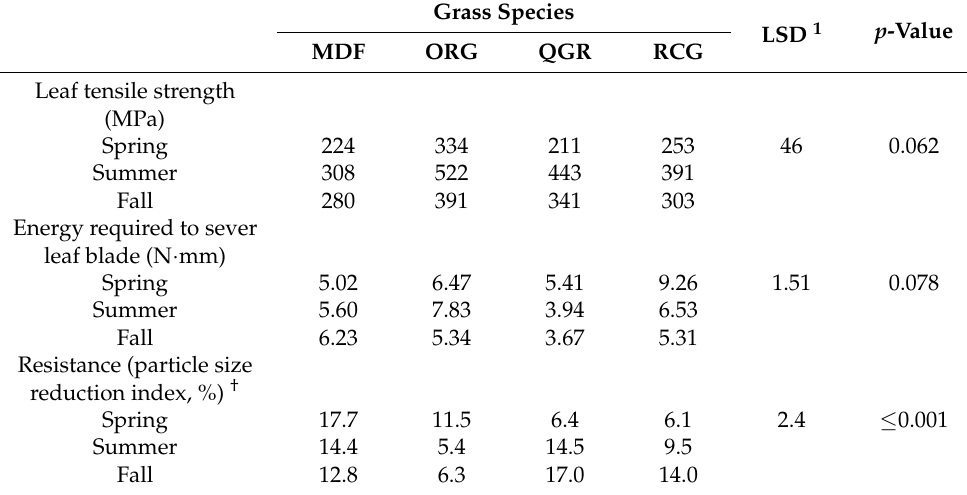
Table 5. Grass species–season interaction for leaf tensile strength, energy required to sever the leaf blade, and resistance to particle size reduction of four grass species (meadow fescue—MDF; orchardgrass—ORG; quackgrass—QGR; reed canarygrass—RCG). Means are average of two years. Grass Species LSD 1 p -Value